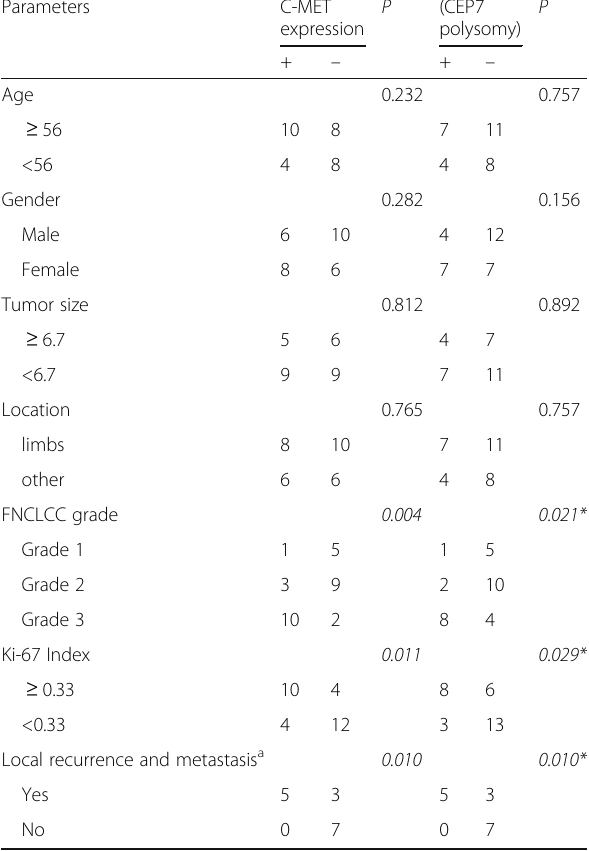
Table 2 Clinicopathological characteristics and associations with MET immunoexpression and chrosome 7 polysomy in 30 MFS Parameters C-MET expression